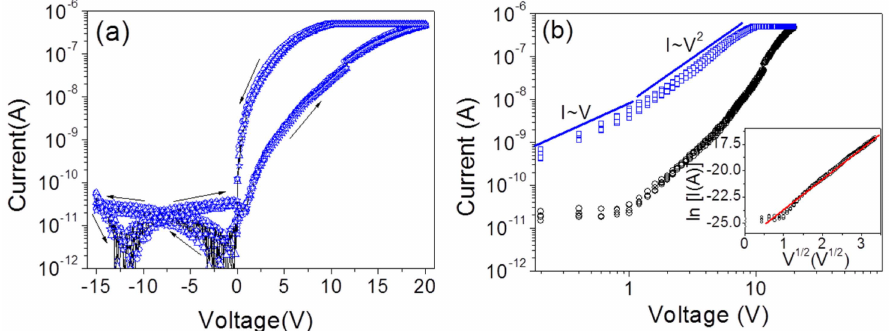
Figure 6. ( a ) Reproducible asymmetric I – V curves of single ZnO NW and ( b ) the I – V curves at positive ? V „ ln p I q for the high resistance state (HRS). bias on log-log scale with the inset fitting of